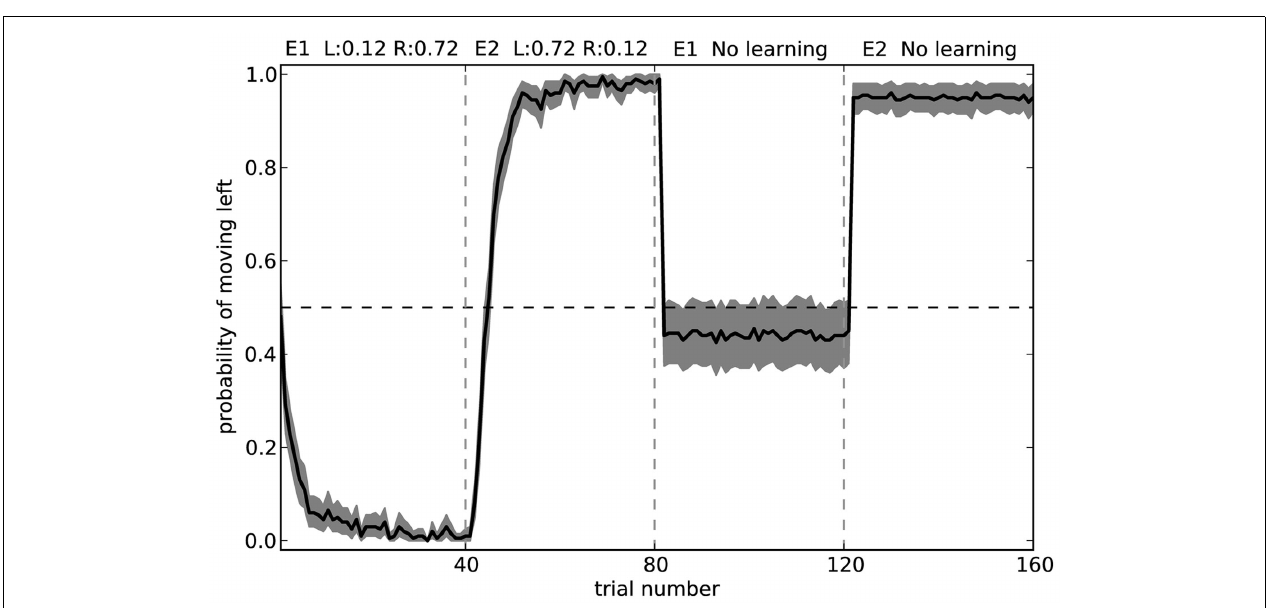
information is fixed (i.e., when the pattern of spikes in the cortex does not change to indicate which of the three environments it is in), the model takes longer to switch actions. Shaded areas are 95% bootstrap confidence intervals over 200 runs.